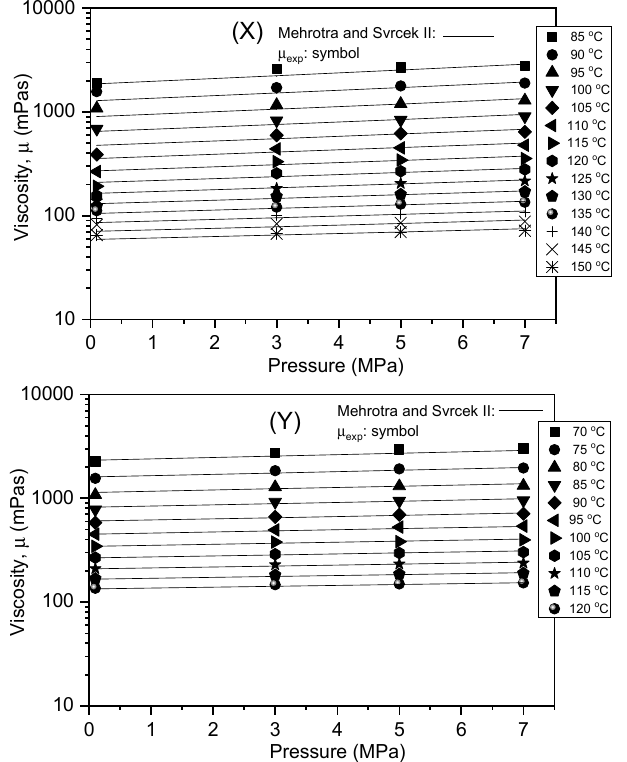
Figure 7. Experimental and calculated viscosities using Equation (4).